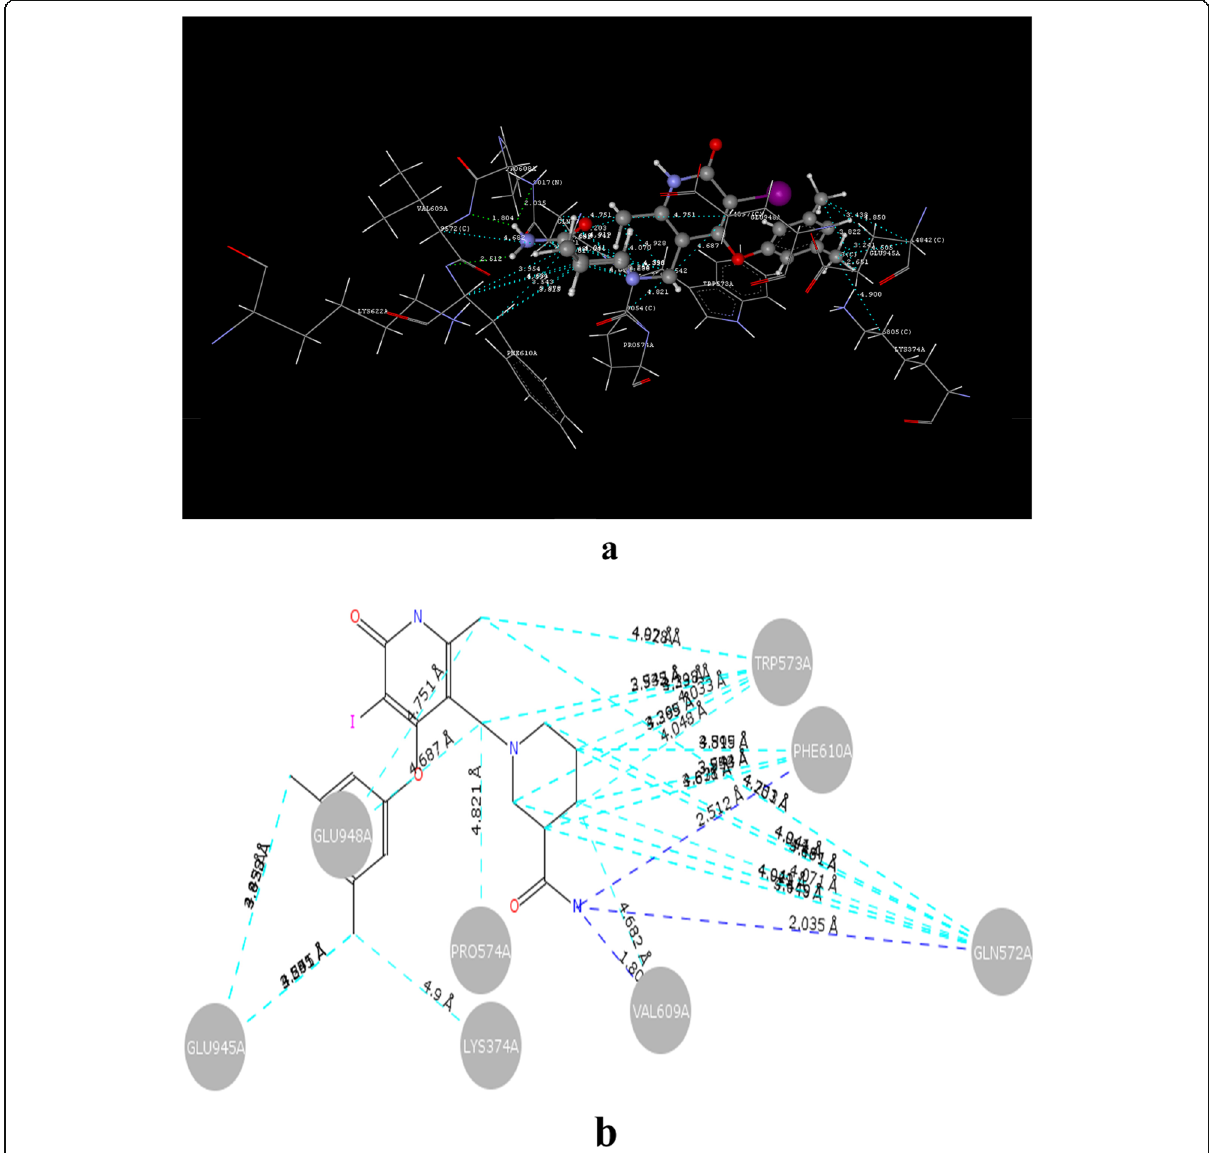
Fig. 7 a Docking pose of compound 51 into active site of 1S6Q. b 2D-ligand interaction diagram of compound 51 in the binding pocket of